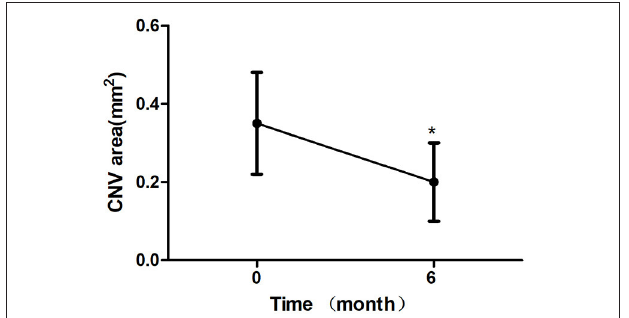
FIGURE 4 | Mean change in central retinal thickness (CRT) over 6 months. The significant improvements in CRT were observed at each follow-up visit compared with baseline values (* P < 0.05). Error bar represents standard deviation.